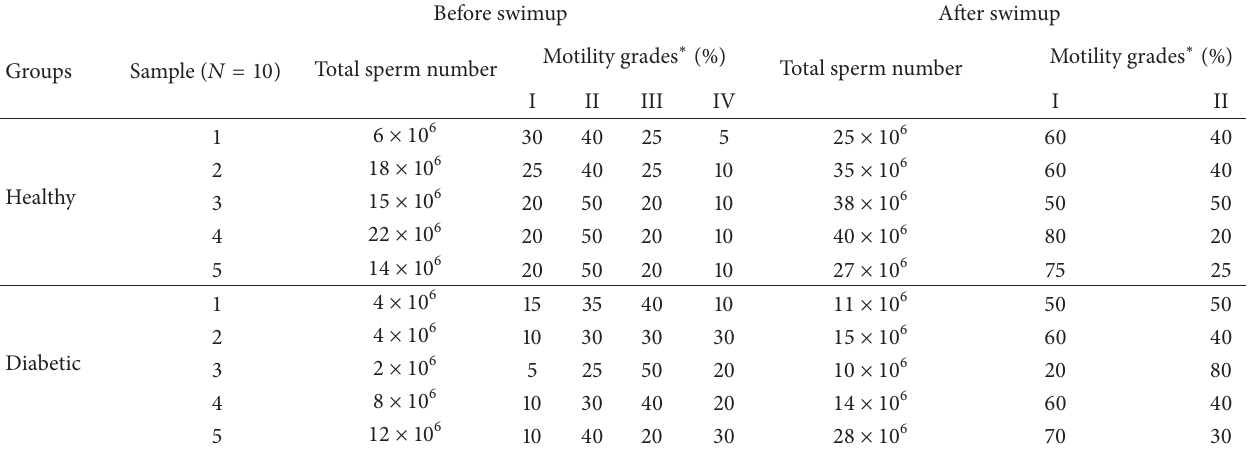
Table 2: Motility grades of control and diabetic rat sperms before and after swimup. Before swimup